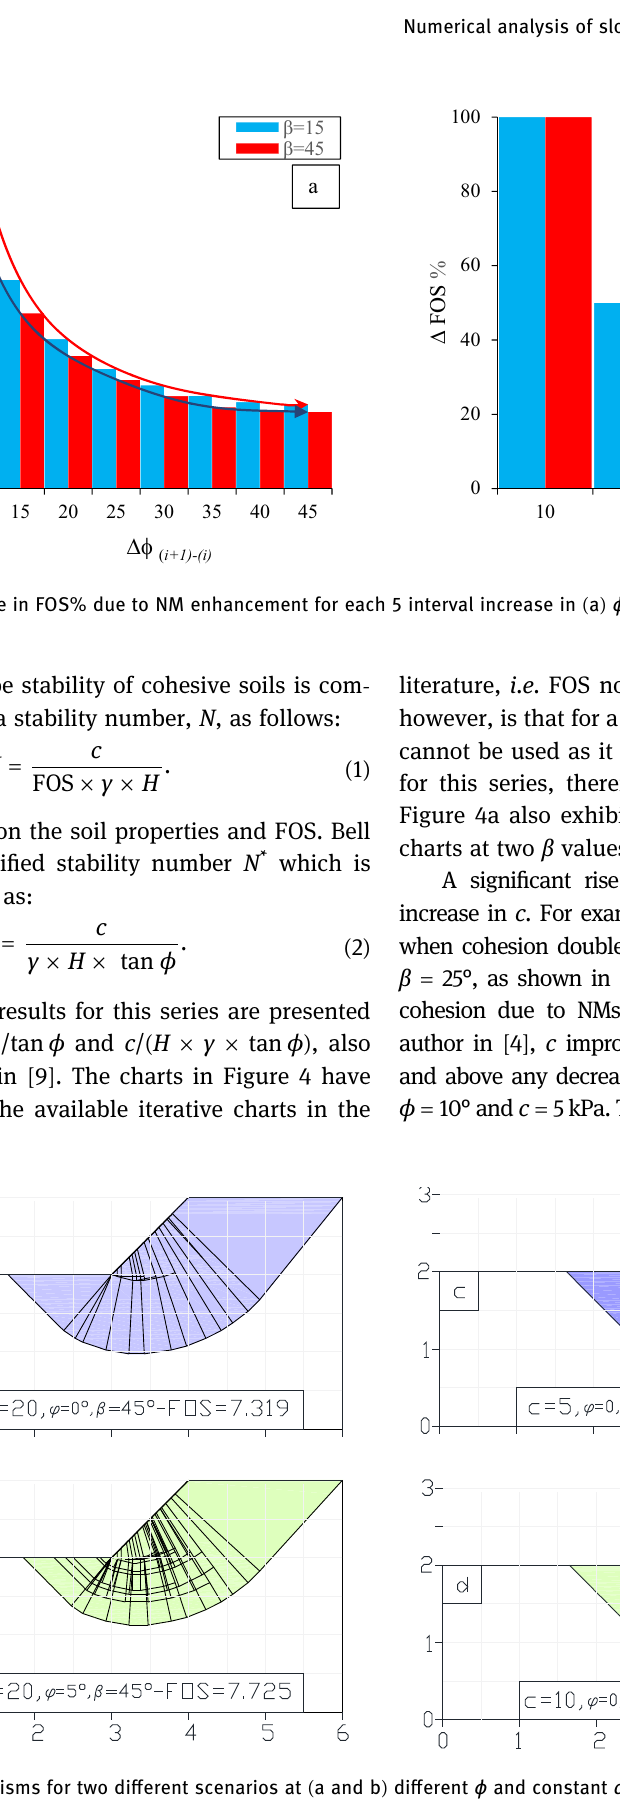
Figure 6: Failure mechanisms for two di ff erent scenarios at ( a and b ) di ff erent ϕ and constant c and ( c and d ) di ff erent c and constant ϕ